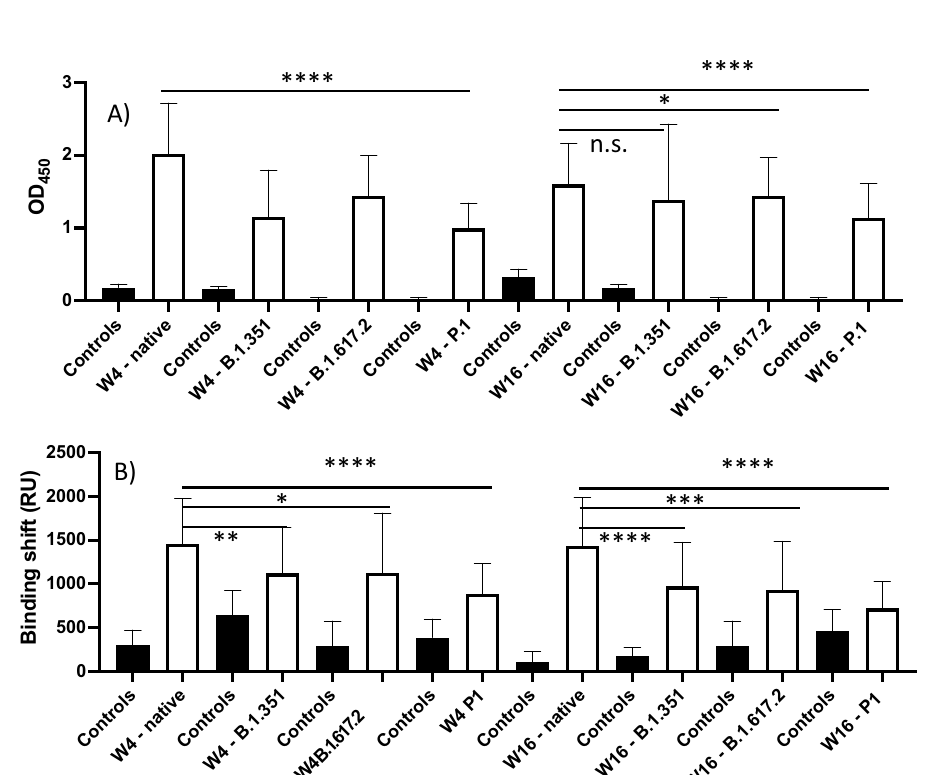
Figure 1. Average ELISA OD 450 ( A ) and SPR binding shifts ( B ) for the detection of anti-spike IgG in SARS- CoV-2-positive sera (n = 32) at week 4 (W4) and week 16 (W16) post-diagnosis for the native, B.1.351, B.1.617.2, and P.1 spike proteins. Controls are sera from SARS-CoV-2-negative individuals who were never diagnosed with SARS-CoV-2 (n = 8). Error bars represent one standard deviation. n.s., not statistically significant, * p < 0.05, ** p < 0.01, *** p < 0.001, and **** p <